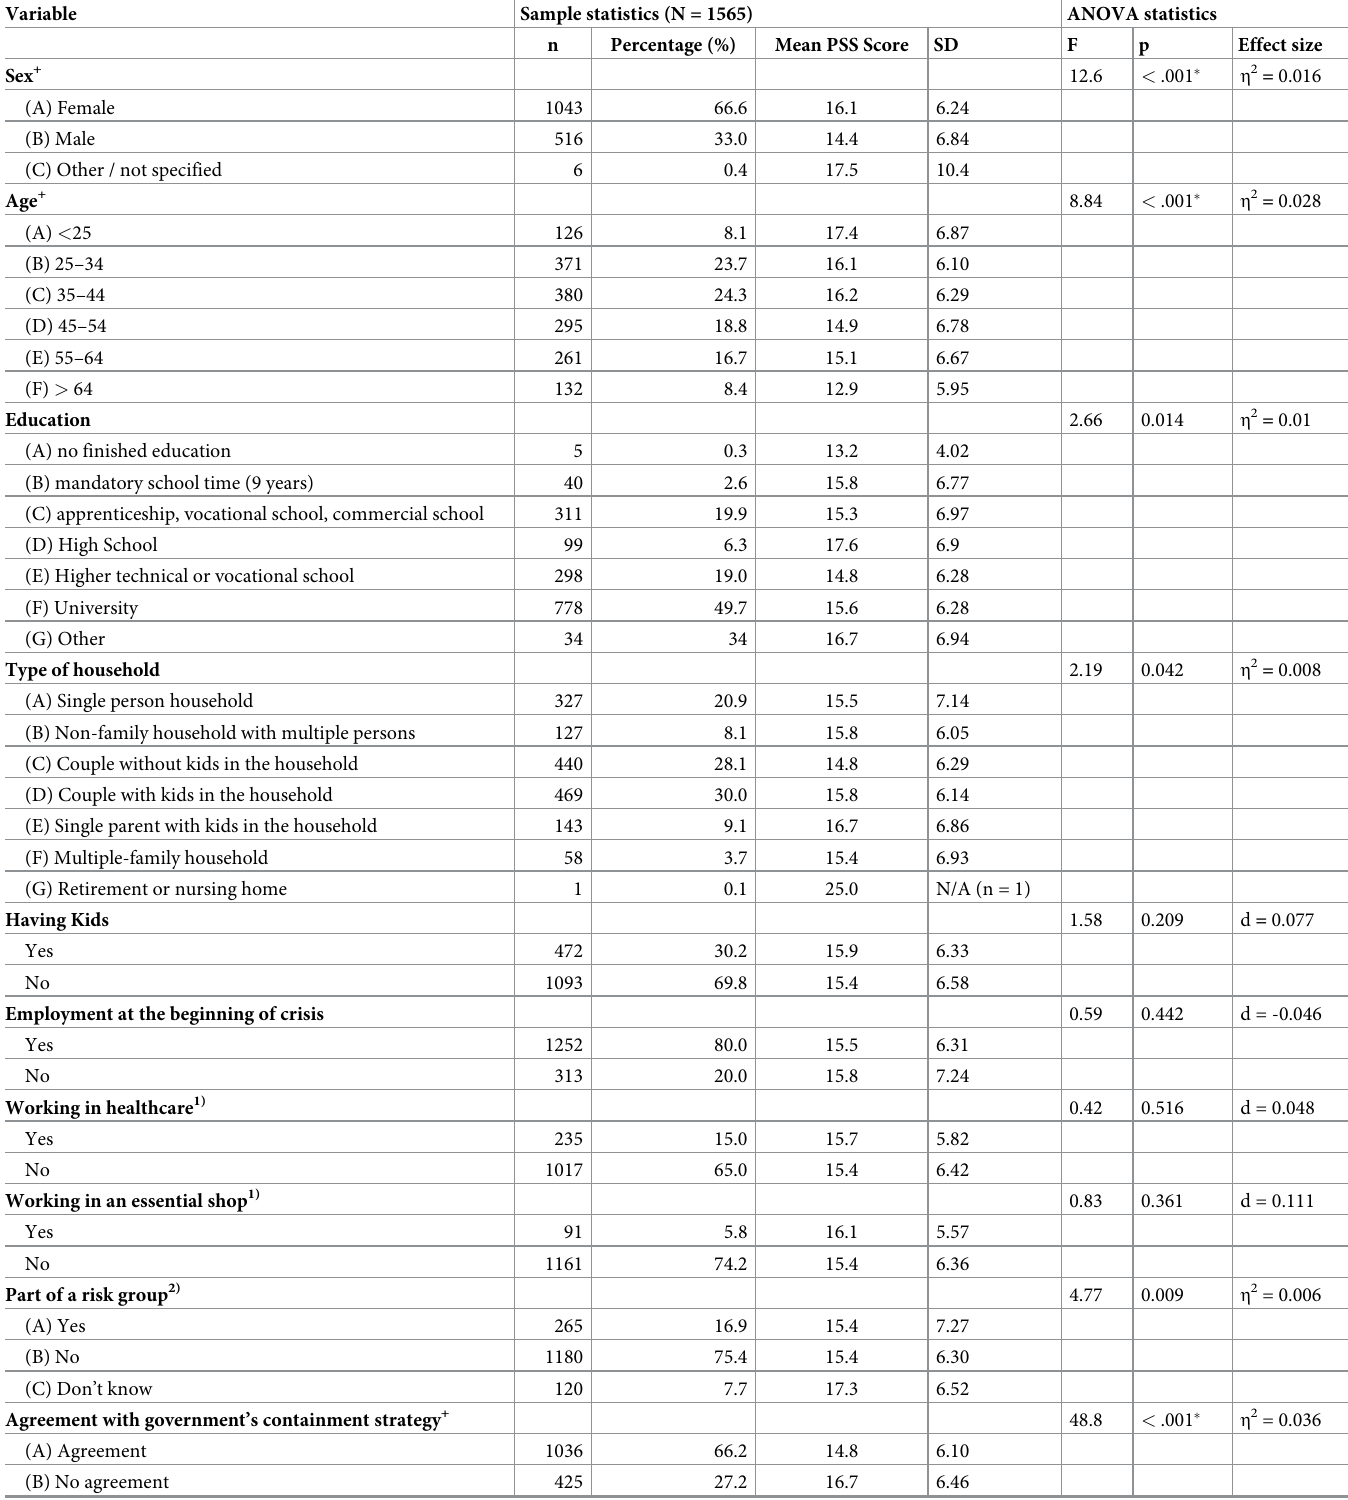
Table 1. Group comparisons of experienced